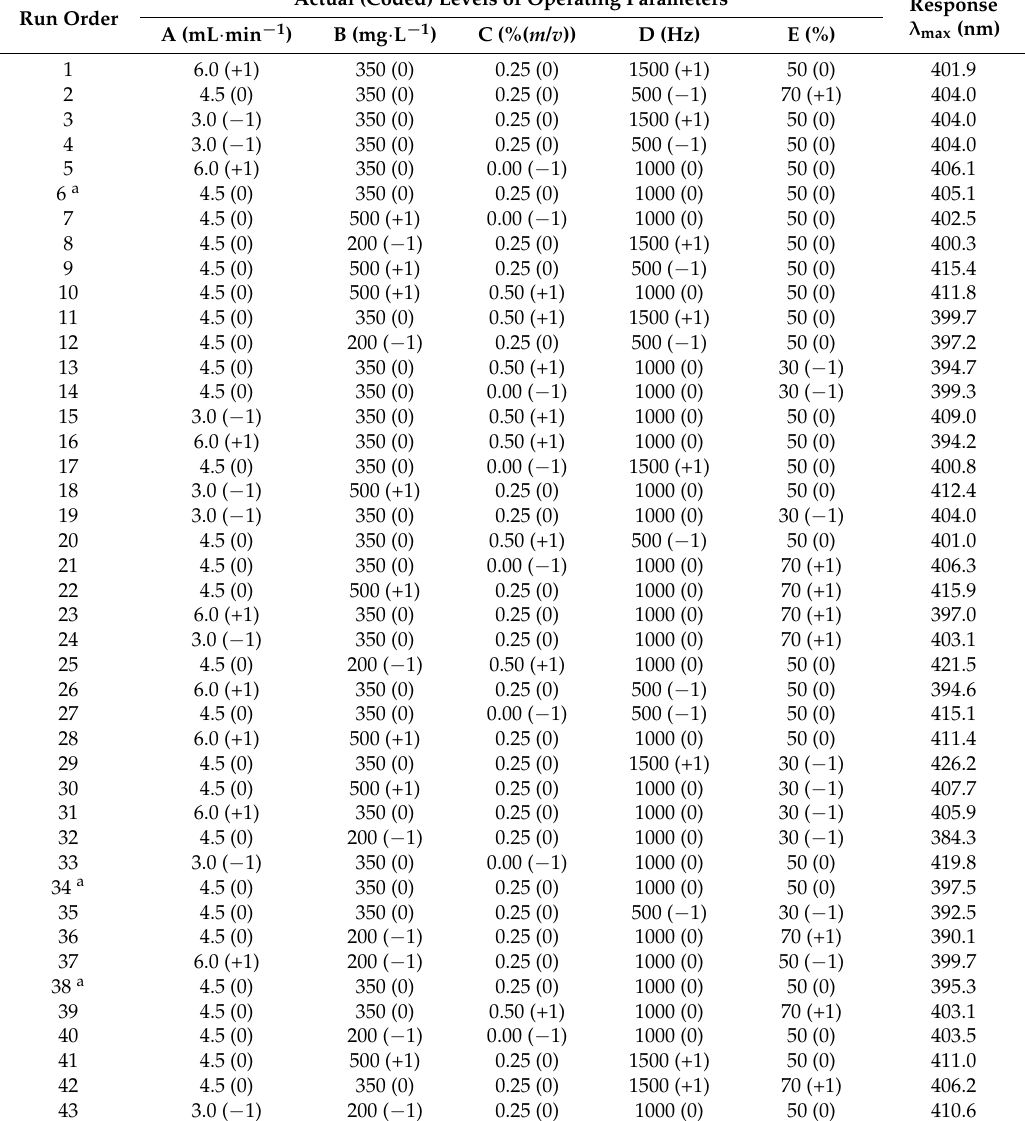
Table 1. The Box–Behnken response surface design with actual and coded values of operating parameters of the pulse-modulated radio-frequency atmospheric-pressure glow discharge (pm-rf-APGD) plasma-reaction system for synthesis of silver nanoparticles (AgNPs), along with the randomized run order and the response, i.e., λ max of the localized surface plasmon resonance (LSPR) absorption band of AgNPs: (A) the flow rate of the flowing liquid electrode solution, (B) the precursor concentration, (C) the pectin concentration, (D) the frequency of pulse modulation of rf current, and (E) the duty